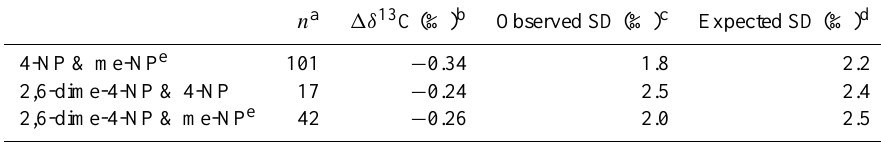
Table 5. Overview of difference in carbon isotope ratios ( (cid:49)δ 13 C) between different nitrophenols analyzed in the same sample.